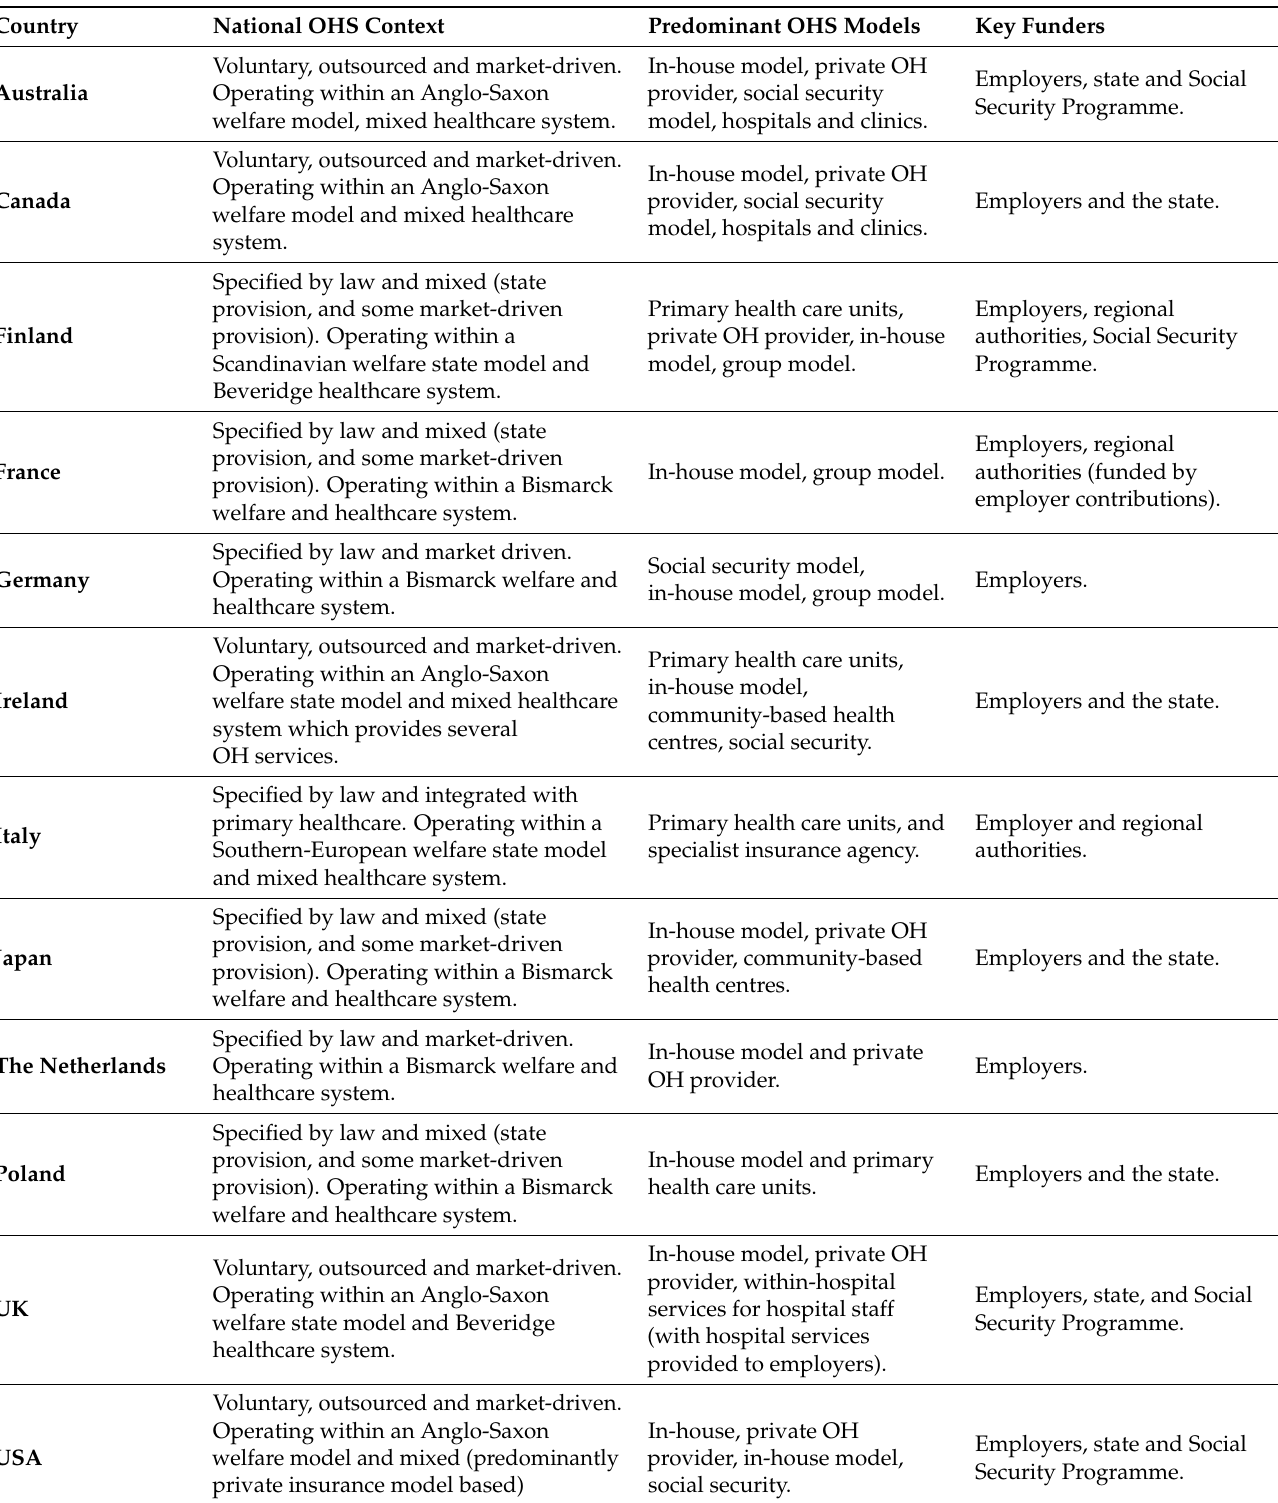
Table 3. Models and financing of occupational health